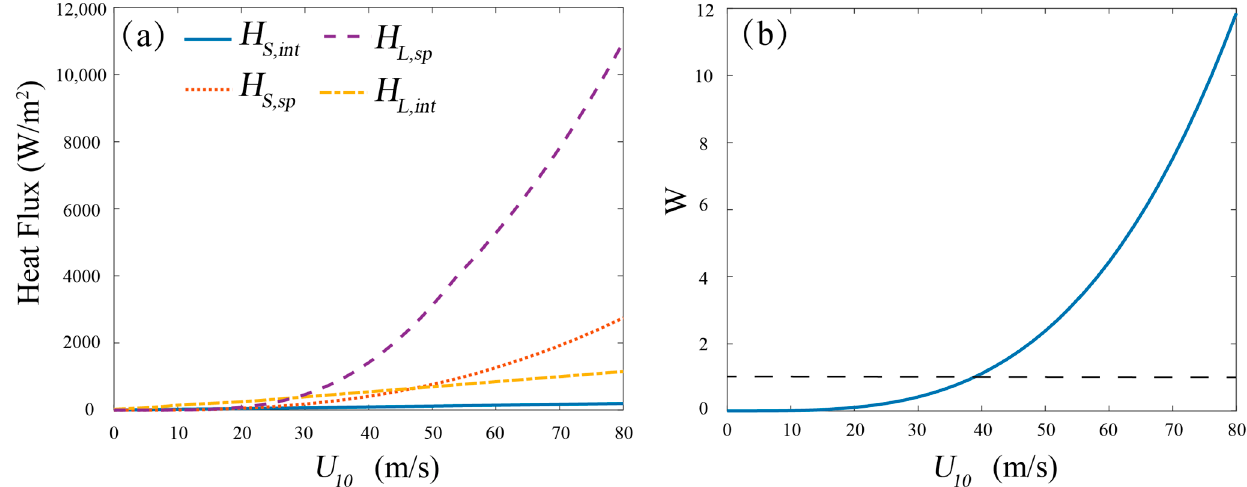
Figure 2. ( a ) Values of the interfacial and spray-induced latent and sensible fluxes calculated by the AN15 algorithm for a range of U 10 under the typical tropical cyclone environment; ( b ) the whitecap coverage W F 94 as a function of the 10 m wind speed U 10 . The dotted line represents the whitecap coverage equal to 1.